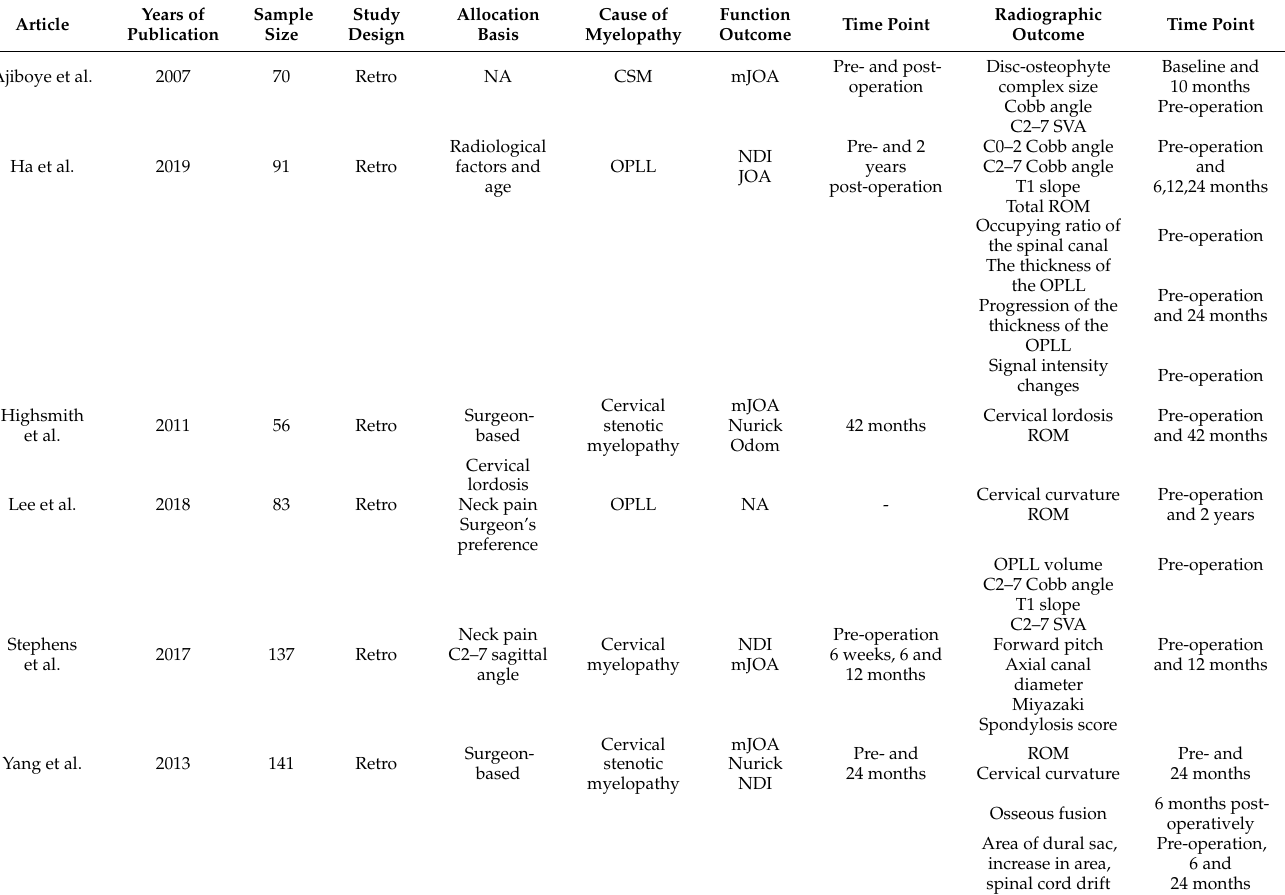
Table 2. Studies describing laminoplasty versus laminectomy with